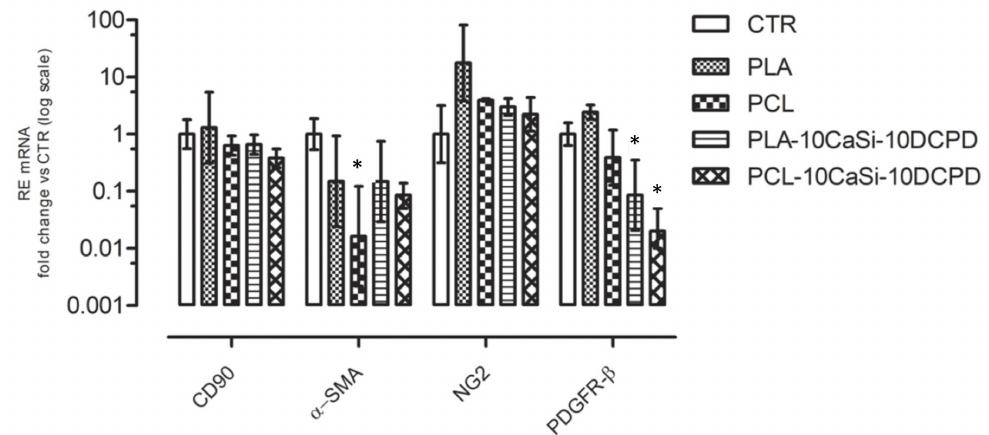
Figure 5. Expression of CD90, α SMA, NG2, and PDGFR- β genes in VW-MSCs evaluated after 72 h of culture in the presence of di ff erent experimental 3D sca ff olds or in 2D standard culture condition (CTR). Data represent mean ± range of relative expression (RE) of three biological replicates (n = 3). Data were analysed using one-way ANOVA followed by the Tukey’s post hoc comparison test. Statistically significant di ff erences among the sca ff olds are represented by asterisks ( * ) ( p < 0.05). On the contrary, PDGFR- β always decreased in both PLA and PCL sca ff olds in the presence of CaSi and DCPD.